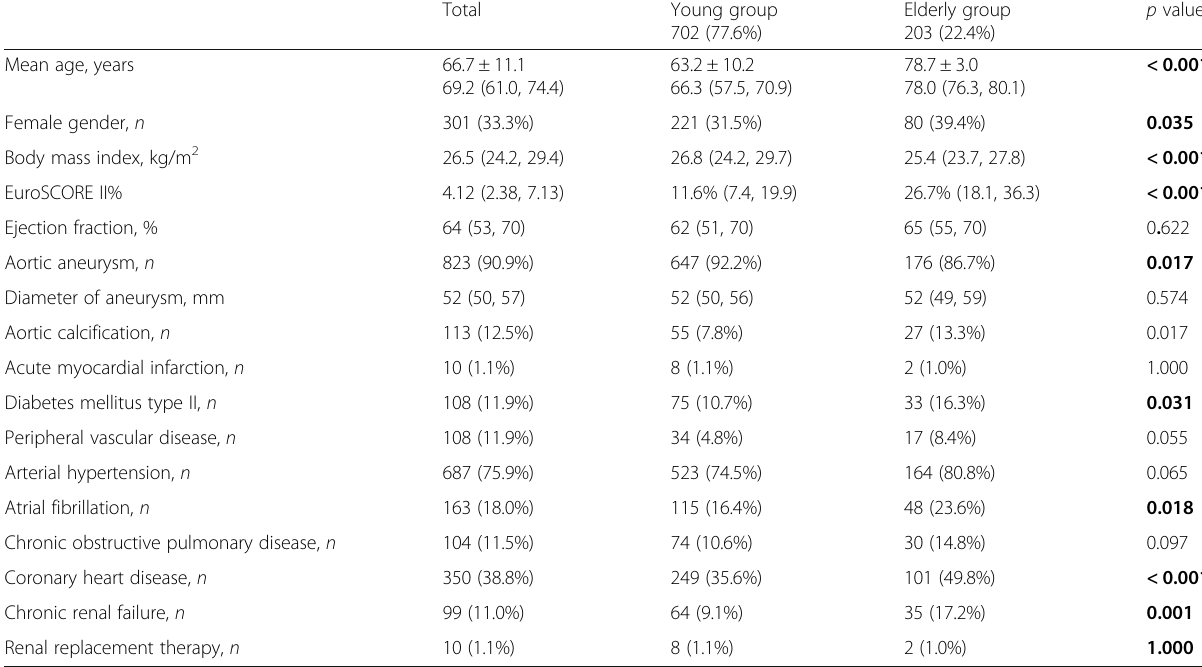
Table 1 Demographic data, preoperative risk